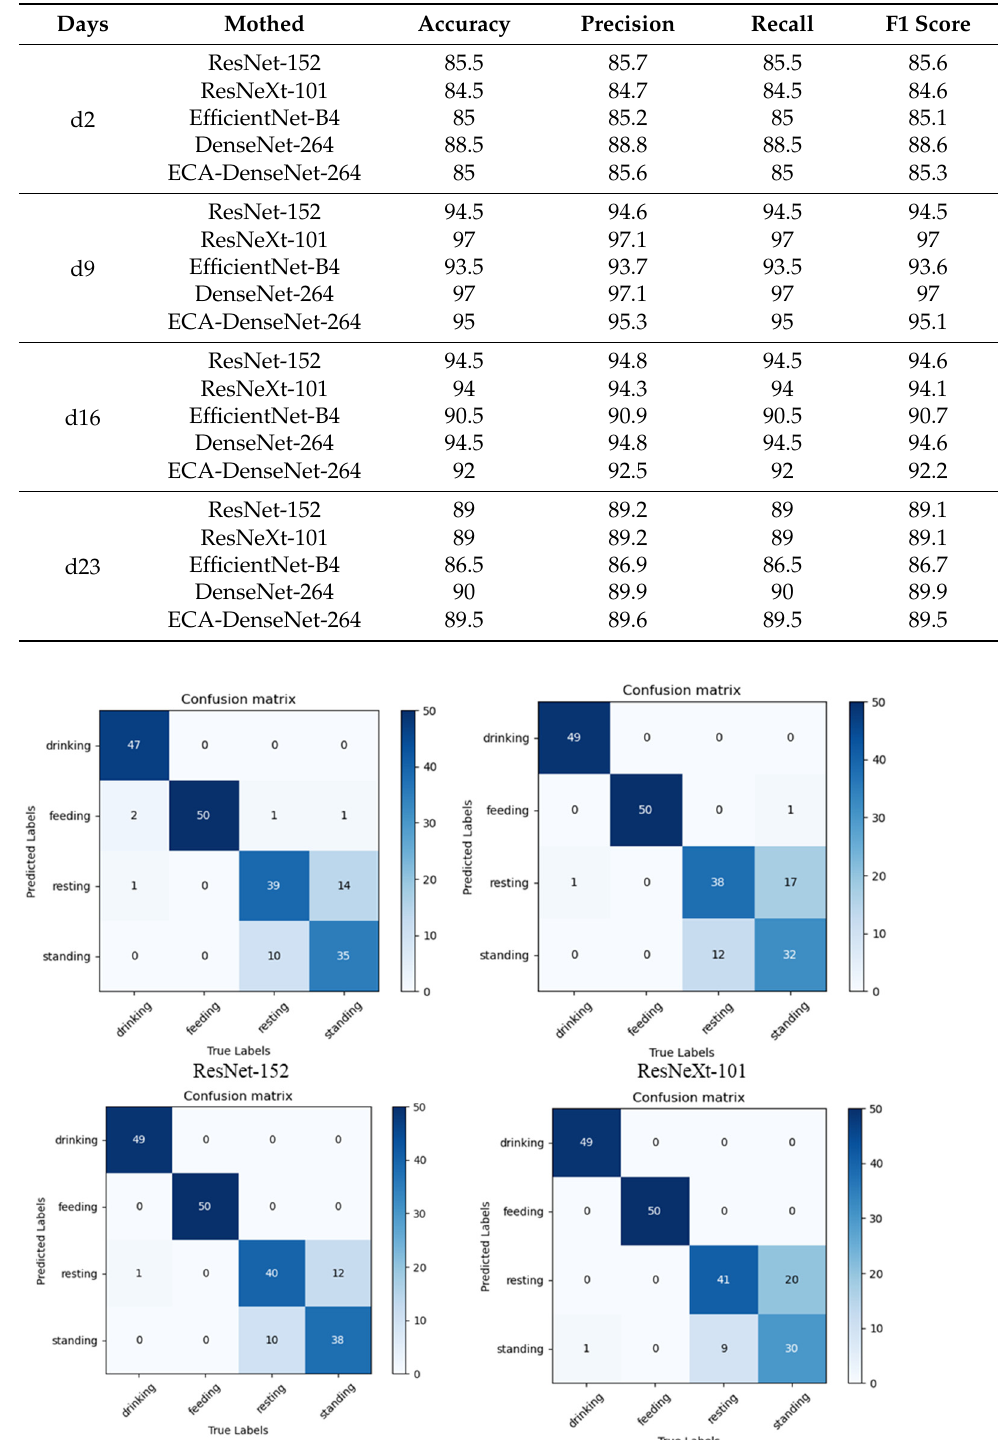
Table 5. Detection results of CNN models for broiler dataset.